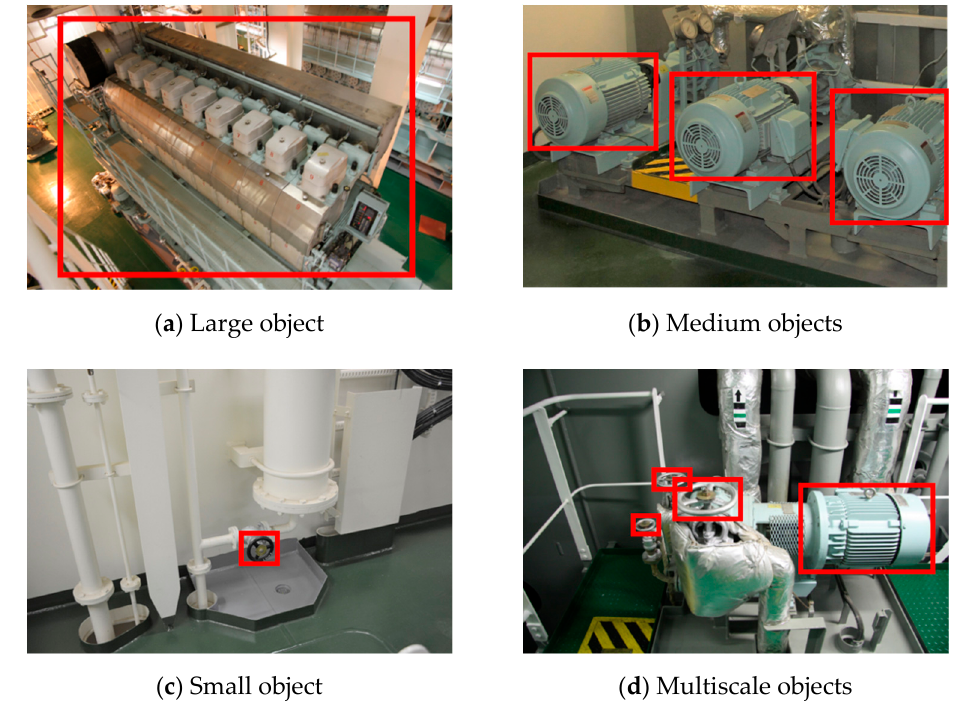
Figure 1. Examples of the multiscale objects in a marine engine room. In ( a ), the engine occupies almost the whole image. In ( b ), the pixels of every pump account for about 10% of the image. In ( c ), the pixels of the tiny valve are less than 1% of the whole image. Here, in ( d ), are some small valves and a middle size valve.